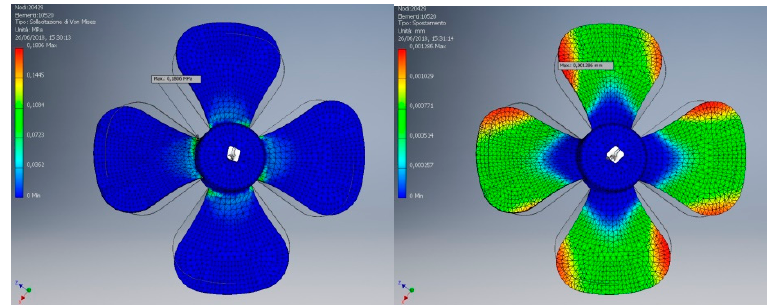
Figure 14. Stress and displacement analysis of the fan.